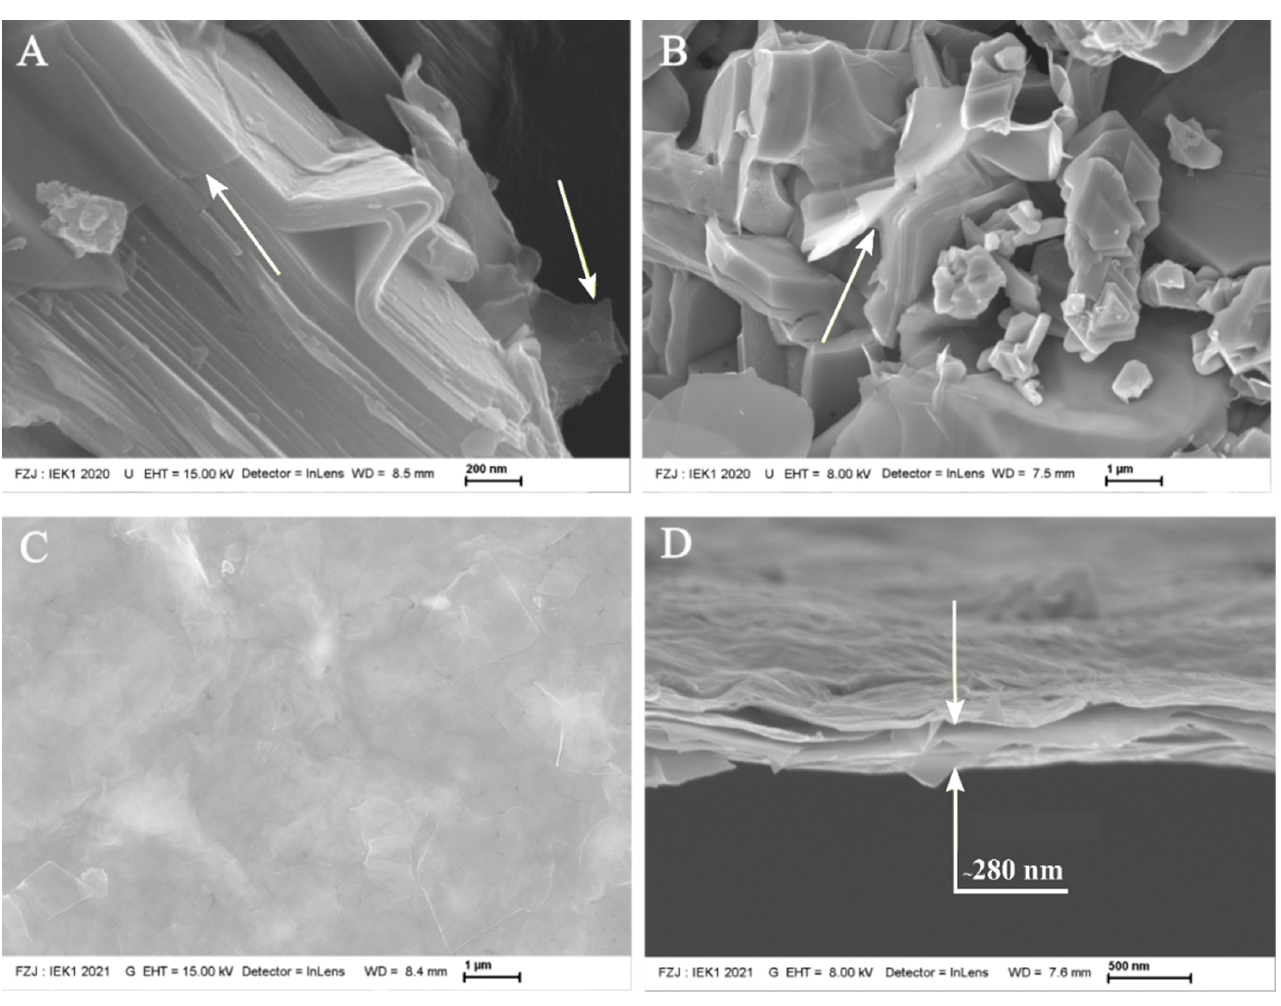
Figure 2. ( A , B ): SEM images of the slurry after the third centrifugation cycle showing the presence of transparent nanosheets, as indicated by the yellow arrows. The free-standing membrane: ( C ) surface morphology and ( D ) fracture surface.